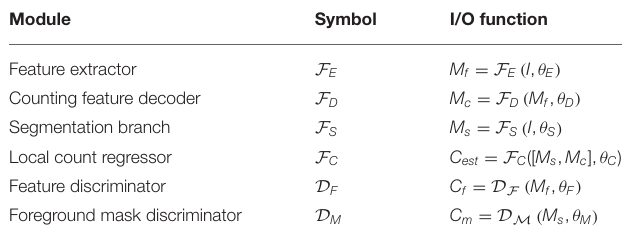
TABLE 2 | I/O for each